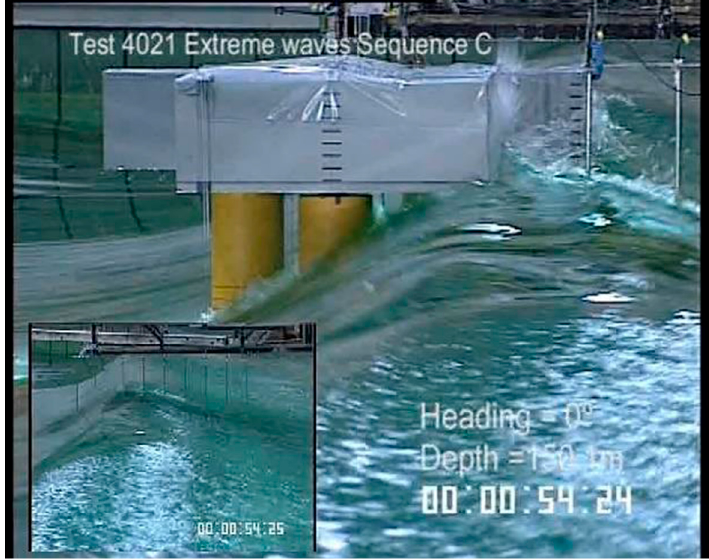
Figure 7. Frozen video frame with random wave impact event on GBS deck. Calibrated wave inserted left.